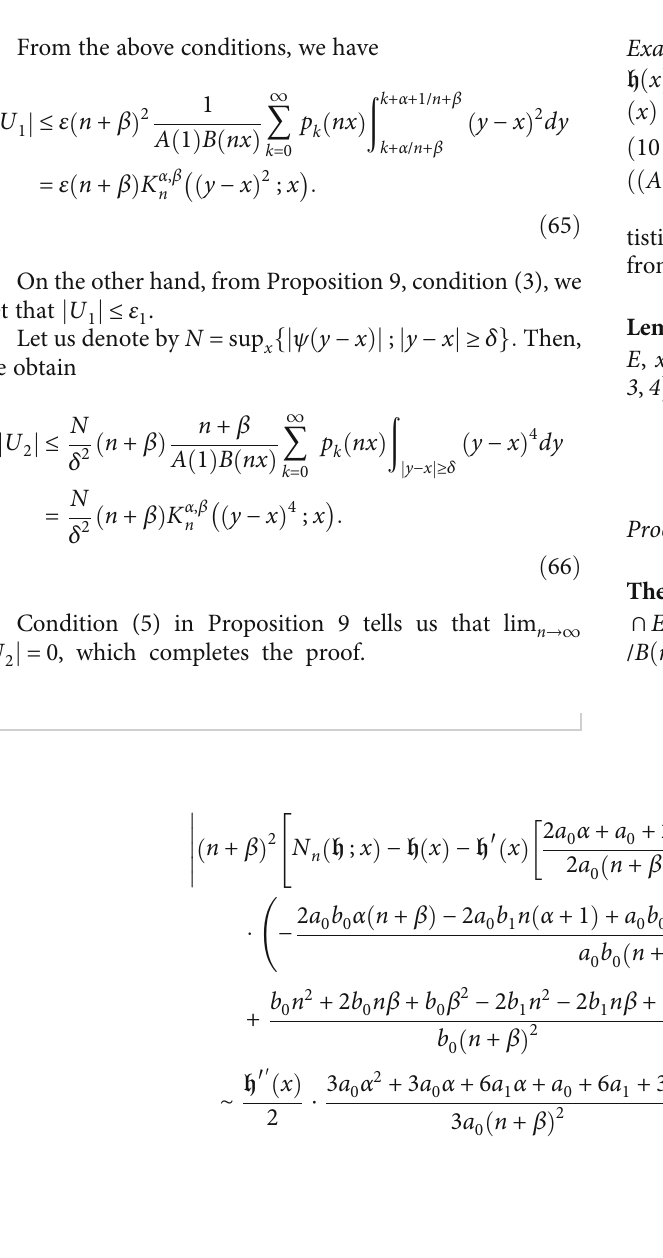
Figure 1: The graphs of ð 10 + β Þ½ K α , β when x ∈ 0,3 : 5 (cid:3)